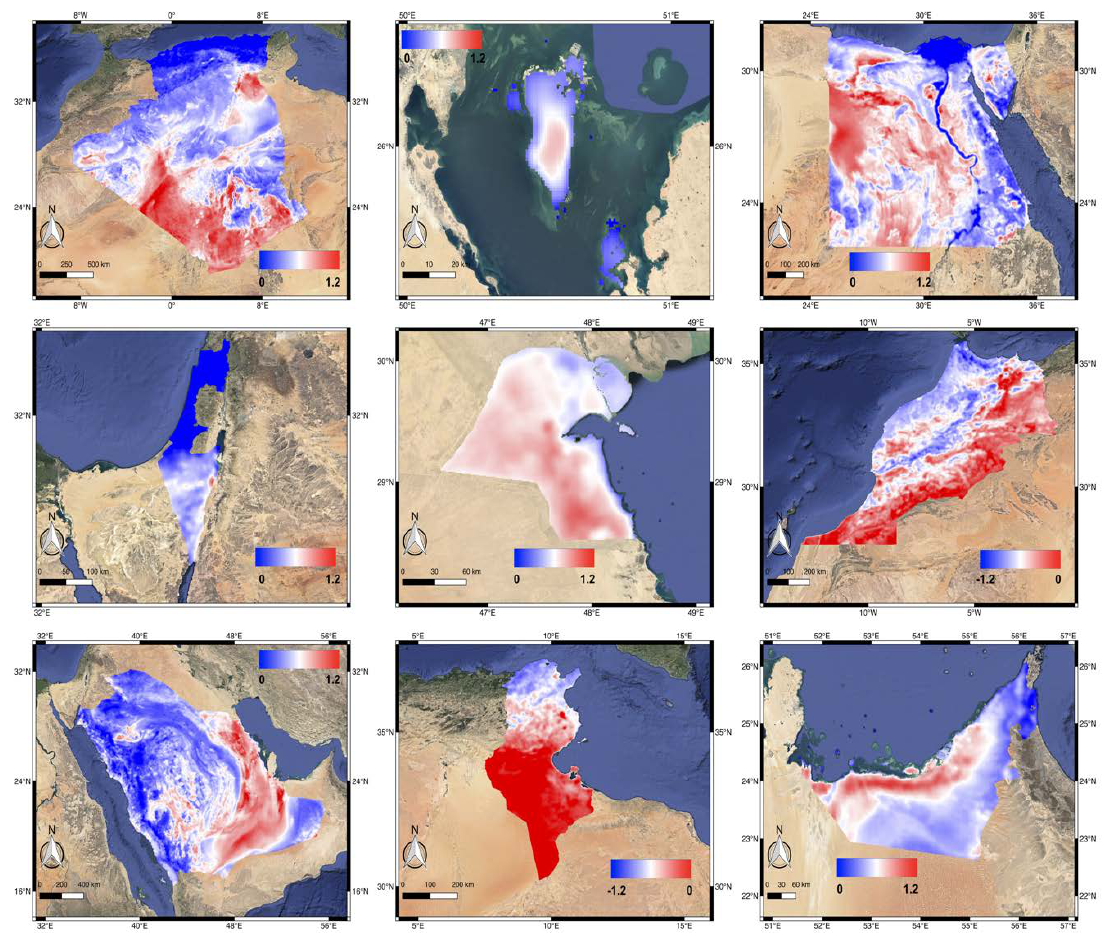
Figure 6. The annually averaged UVAI distribution map of the nine MENA countries (from left to right, top to bottom: Algeria, Bahrain, Egypt, Israel, Kuwait, Morocco, Saudi Arabia, Tunisia, and UAE) from July 11, 2018 till July 10, 2019.